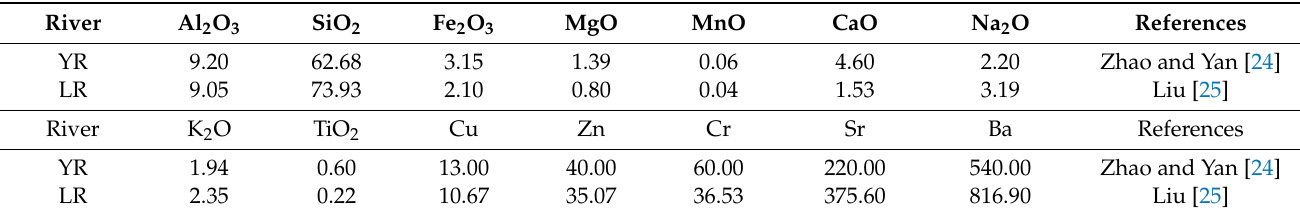
Table 1. Element Content of Sediment in the Yellow River and Luanhe